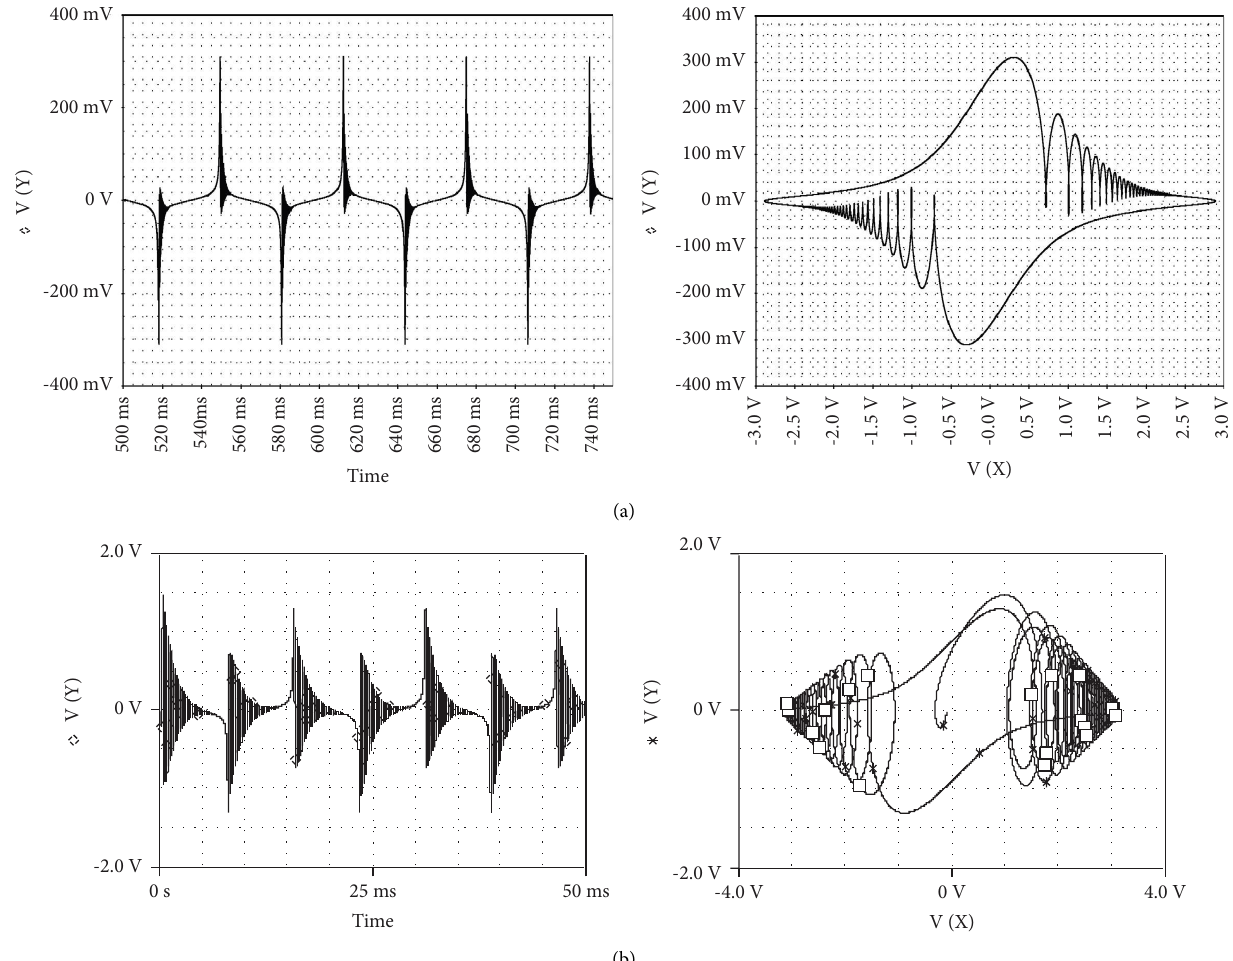
Figure 15: PSpice implementation of the time-history of the variable X (lhs) and phase portraits (rhs) for (a) the periodic and (b) chaotic bursting oscillations of the system obtained with parameters of Figure